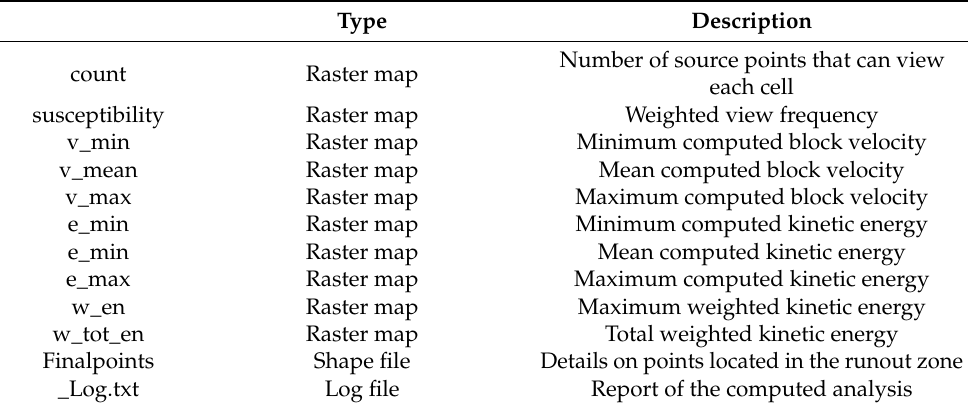
Table 2. List of the QPROTO output files provided at the end of the